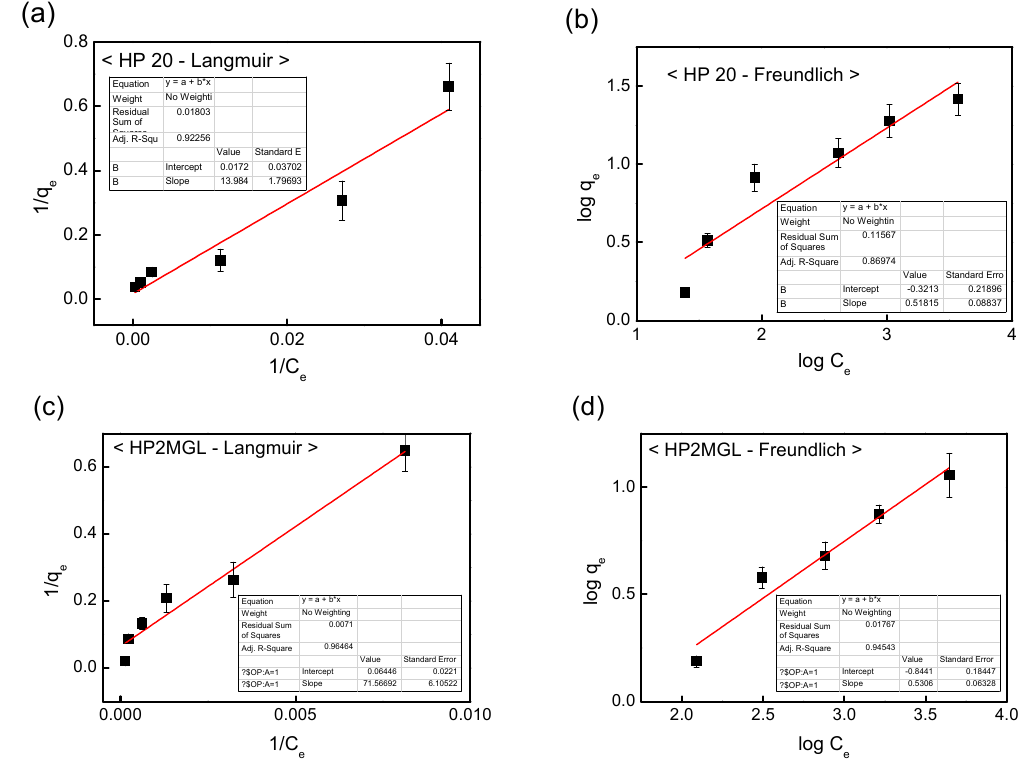
Figure 9. Langmuir ( a , c ) and Freundlich isotherm models ( b , d ) for the adsorption of SDBS onto MARs, HP20 ( a , b ) and HP2MGL ( c , d ). [adsorbents] = 5 mg/mL; [SDBS] = 0.1–5 mg/mL; adsorption time 7 h.